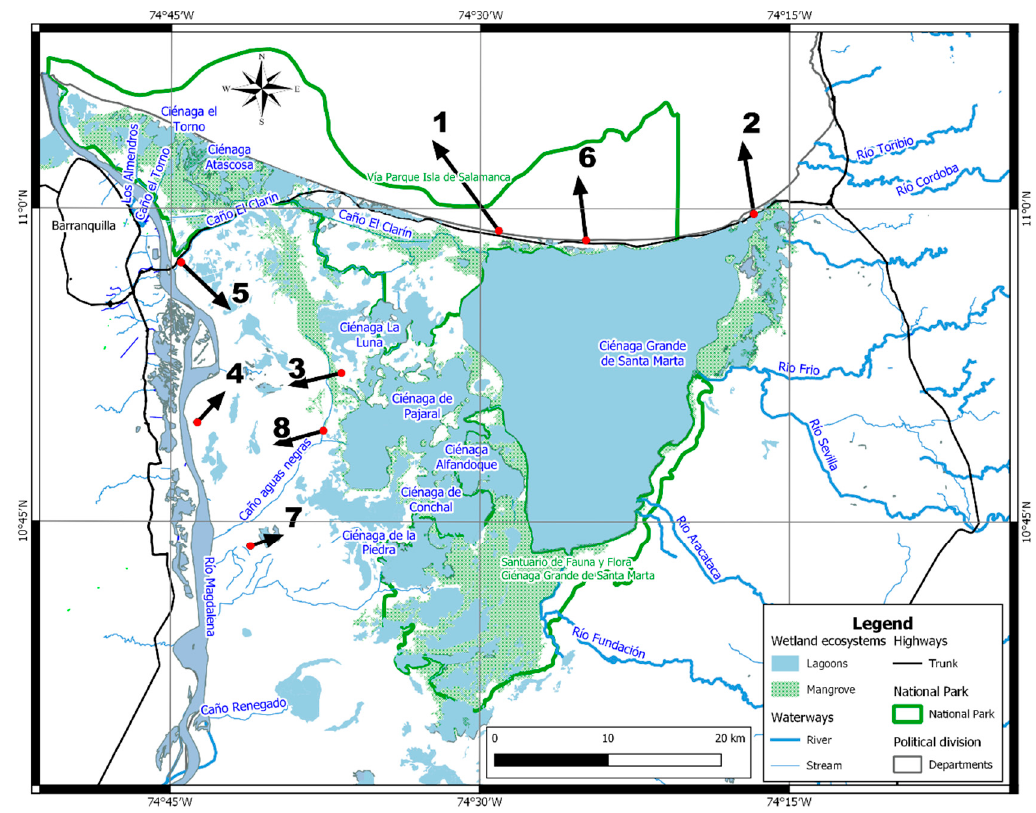
Figure 8. Factors a ff ecting the Ci é naga Grande and Pajarales lagoon complex. 1. Ci é Figure 8. Factors affecting the Ciénaga Grande and Pajarales lagoon complex. 1. Ciénaga–Barranquilla road (1956–1963). 2. Change in the position of the inlet, from Pueblo Viejo to “La Barra” (1956). 3.